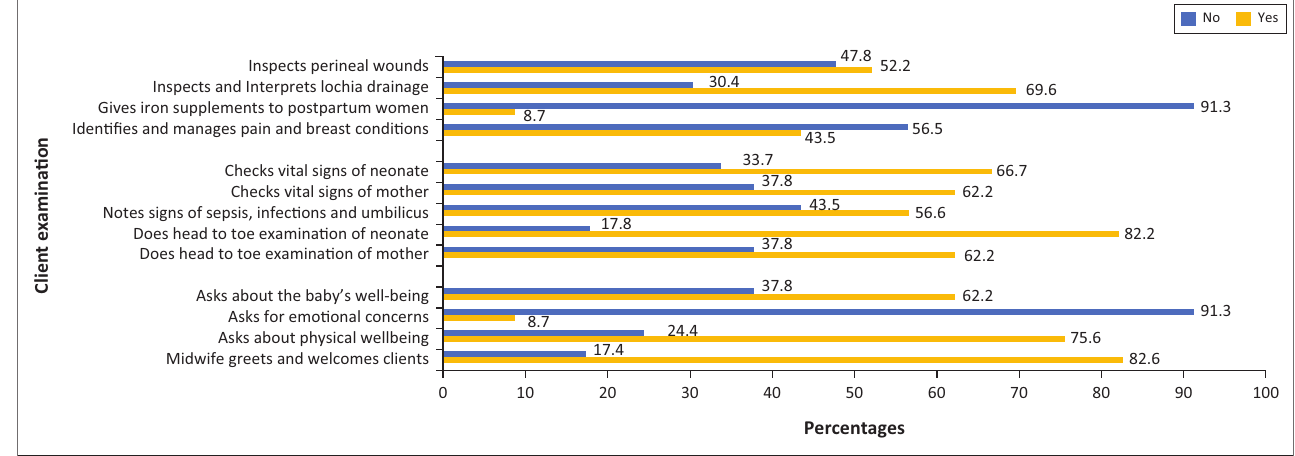
FIGURE 2: Midwives’ practices of client examination during postnatal